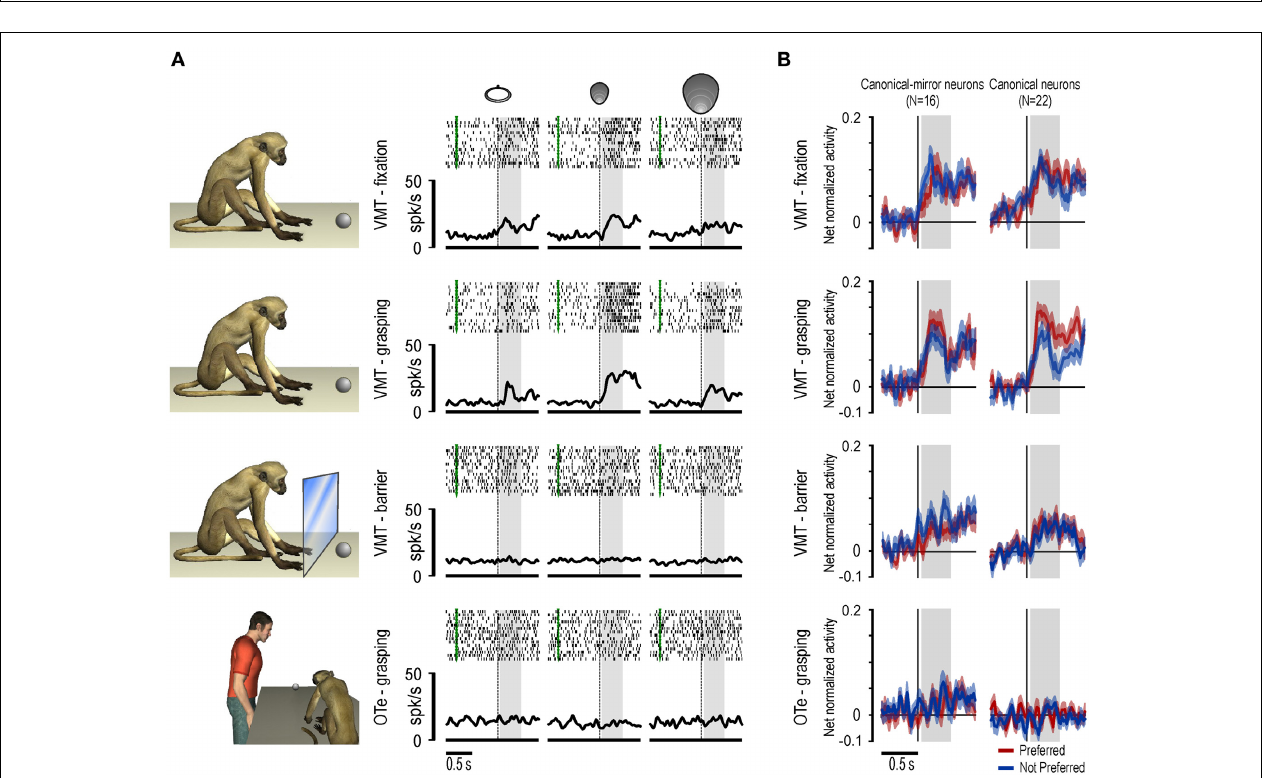
FIGURE 1 | Continued of events and temporal constraints of the OTe and OTp were the same as in the monkey VMT, and the monkey had to simply maintain fixation in order to get the reward. (C) Examples of canonical-mirror neurons recorded in all the task contexts. On the left, a schematic view of the experimental paradigm. Each panel shows, from top to bottom, rastergrams and the spike density function. The gap in the rastergrams and histograms is used to indicate that the activity on its left side has